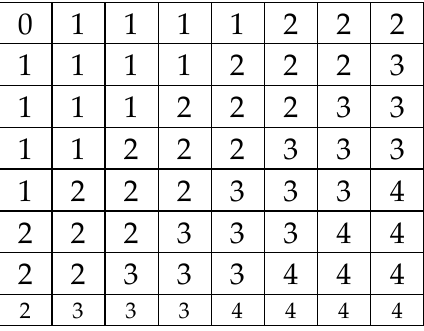
Figure 10. Four spectral areas in the 2D DCT domain.